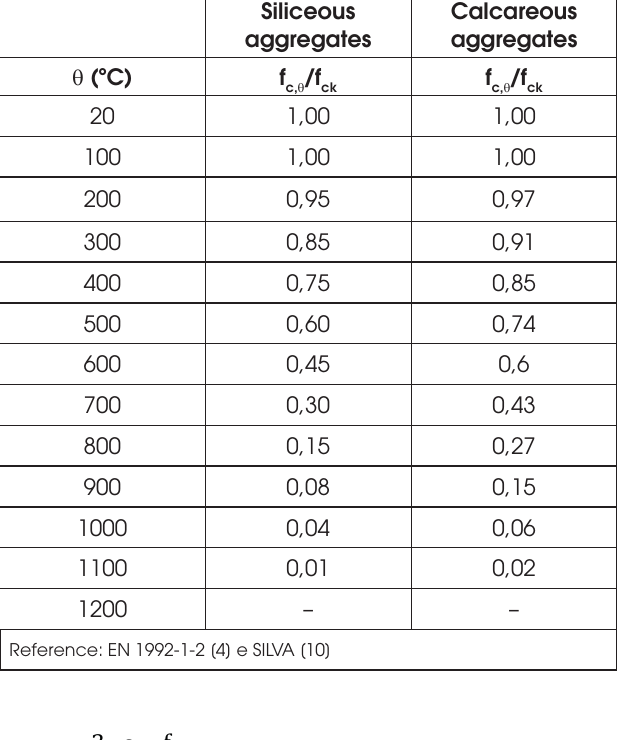
Values for the parameter f weight concrete